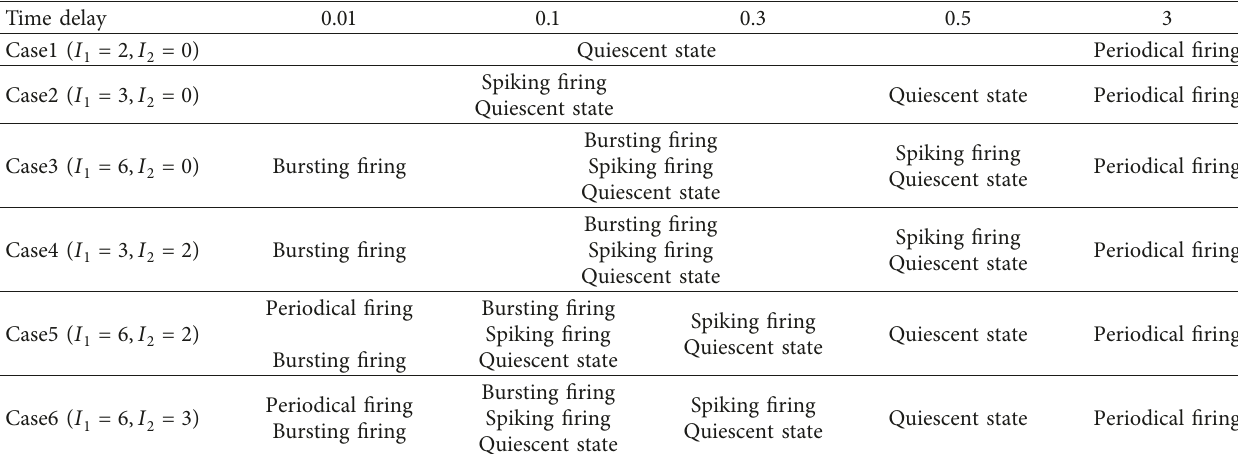
Table 2: Two HR neurons with different firing patterns are coupled to achieve the synchronization state under six kinds of cases. Time